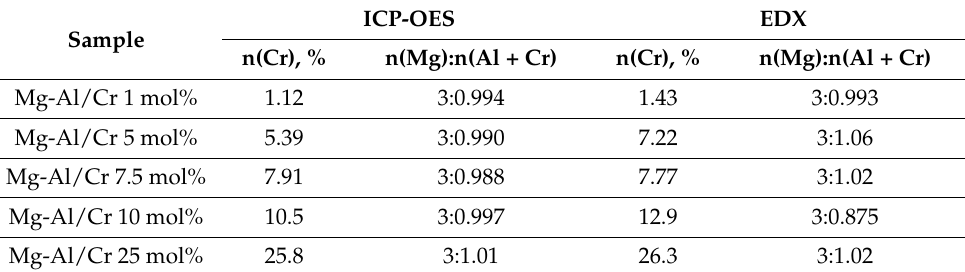
Table 2. Inductively coupled plasma–optical emission spectrometry (ICP-OES) and the energy- dispersive X-ray (EDX) analysis results of elemental analysis of synthesised Mg 3 Al 1-x Cr x LDHs (n is mole).